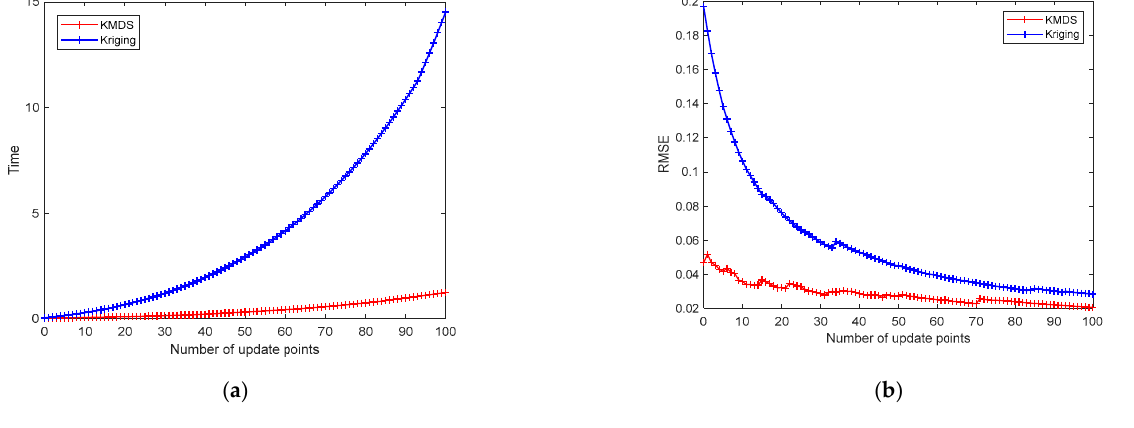
Figure 14. ( a ) Trends of modeling time. ( b ) Trends of RMSE.